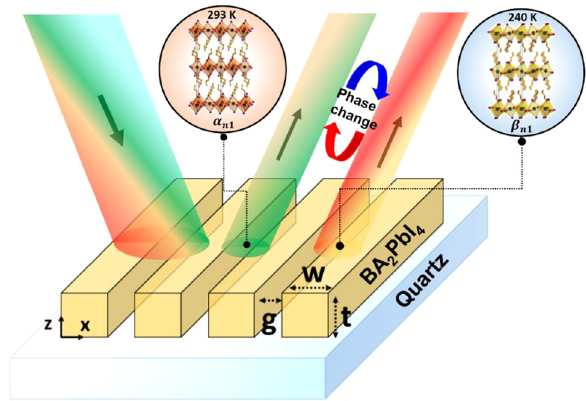
Figure 1: Phase-change perovskite metasurface with dynamic color tunability. Schematic of a tunable phase-change BA nanograting metasurface on quartz substrate. The reflected color is dynamically controlled through the switching of crystallographic phases of the perovskite by altering the ambient